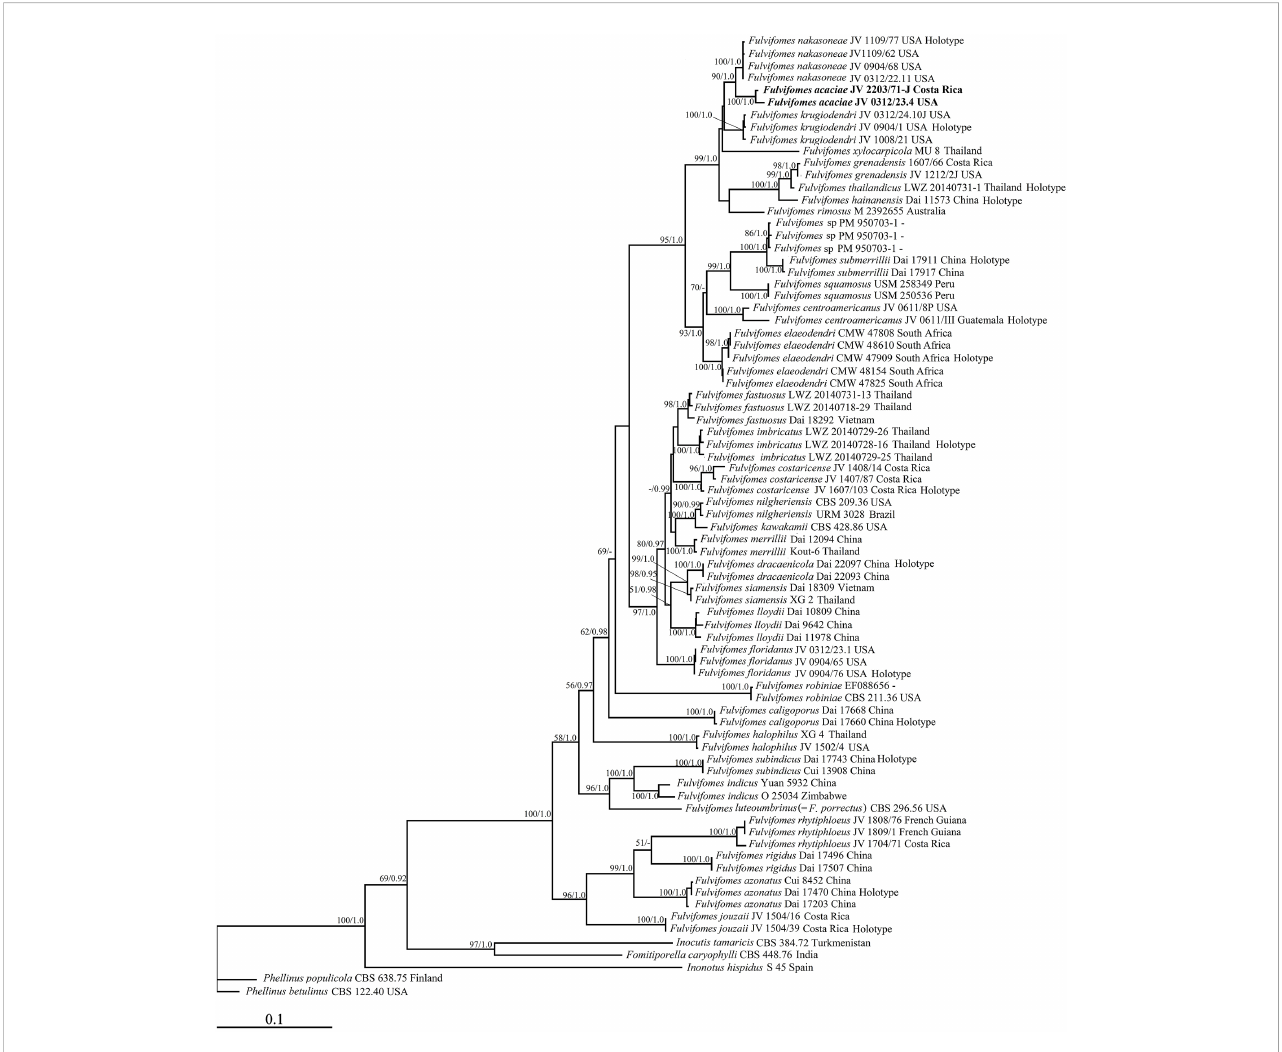
FIGURE 1 Maximum likelihood tree illustrating the phylogeny of Fulvifomes based on the combined dataset of ITS+28S sequences. Phellinus betulinus (MH856059; MH867554) and P. populicola (MH860960; MH872729) were used as outgroups. The maximum likelihood bootstrap values ( ≥ 50) and Bayesian posterior probability values ( ≥ 0.90) are indicated above the branches. The new species is in